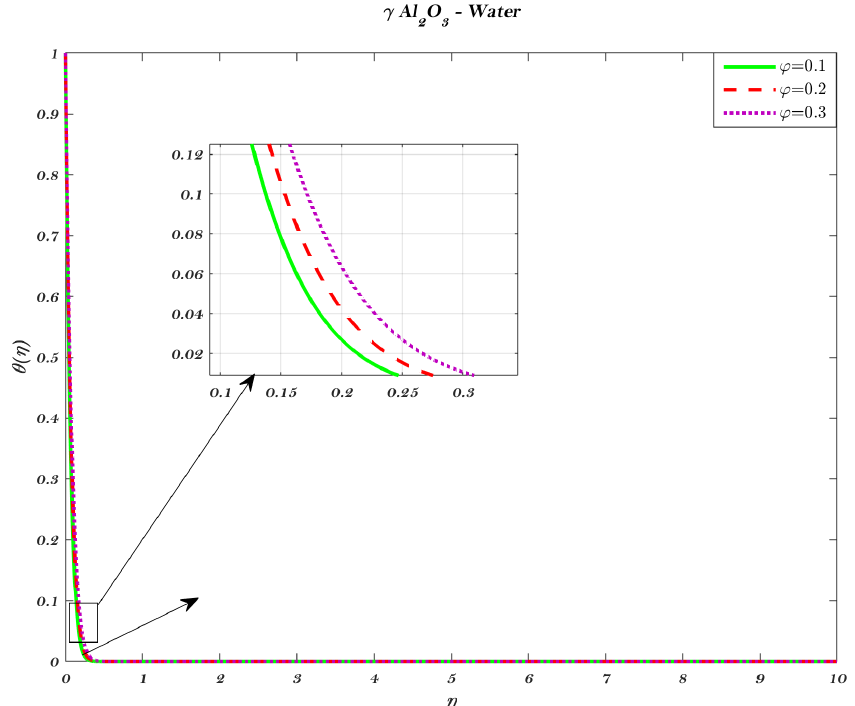
Figure 5. Temperature profile as a function of nanoparticle volume fraction ϕ with fix parameters (cid:101) = 0.02 ˘ a = 0.01, P r = 6.96 and R =